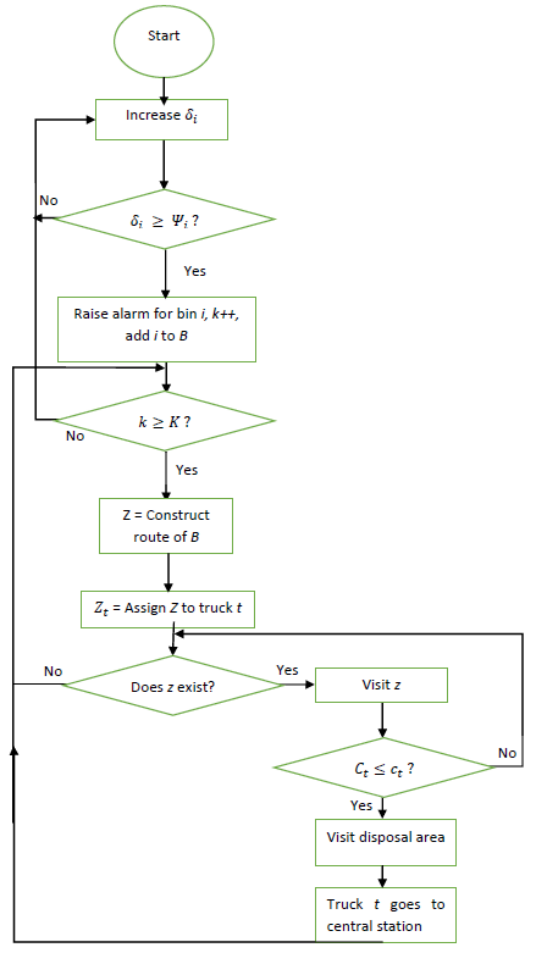
Figure 2. Closest Vehicle First (CVF)